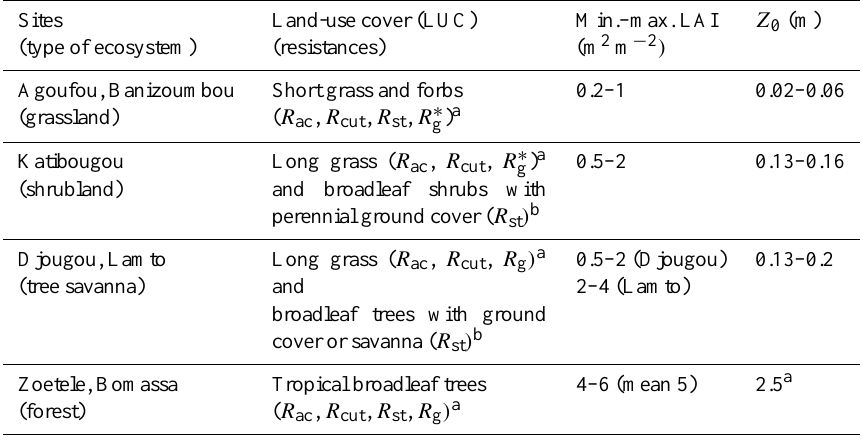
Table 3. Adaptation of land-use categories (LUC) used in the big-leaf model to IDAF sites for the calculation of canopy resistances ( R ac , R cut , R st ) in V d and range of LAI and Z 0 (roughness